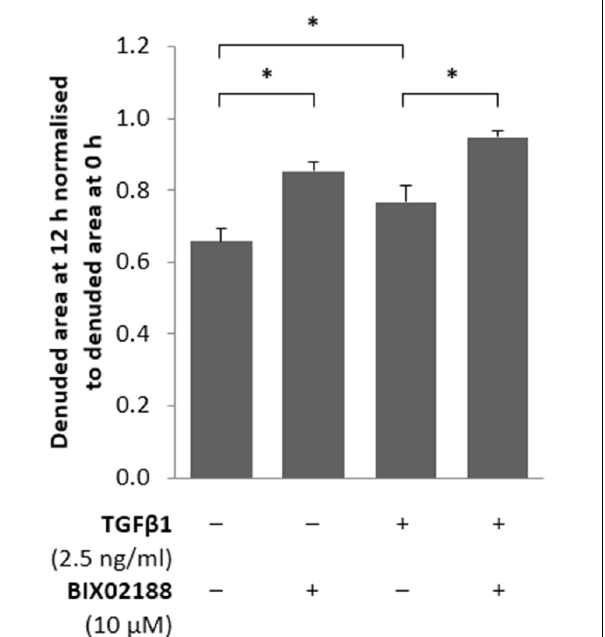
FIGURE 3 | Regulation of podocyte motility via Erk5. Podocytes pre-incubated for 60 min with the Mek5 inhibitor BIX02188 (10 μ M), after which the monolayer was scratched and subsequently co-treated with TGF β 1 (2.5 ng/ml) for 12 h. Inhibition of Erk5 activity decreased podocyte motility as didTGF β 1 treatment and co-treatment further augmented the reduction in motility observed; data normalized to the denuded area measured at 0 h. * P < 0.05; paired t -test, n =